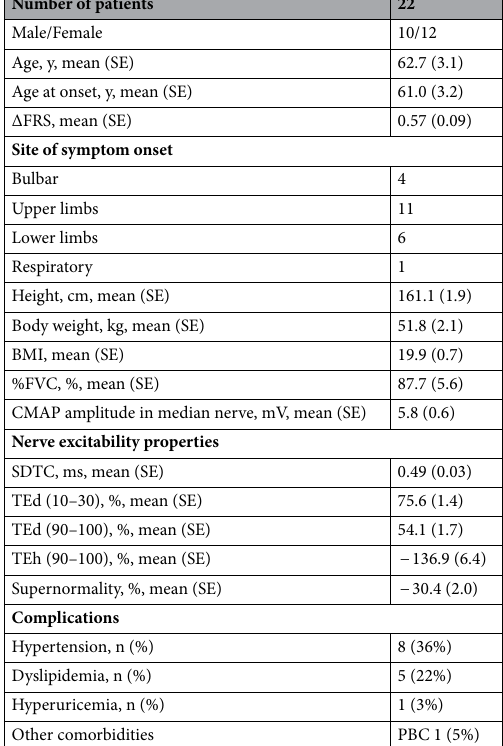
Table 4. Characteristic of the second amyotrophic lateral sclerosis group (n = 22). SE standard error, ΔFRS progression rate (ratio of Functional Rating Scale score to time), BMI body mass index, %FVC percent